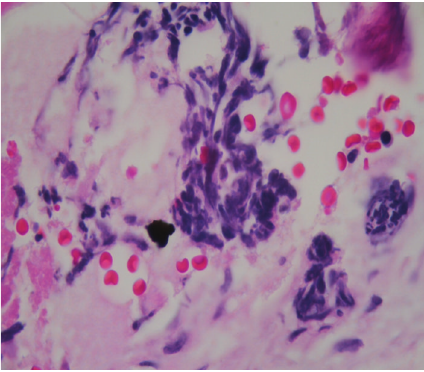
Figure 1: Chest X ray with no abnormal findings. Table 1: Serum potassium values in response to potassium supple- ments.